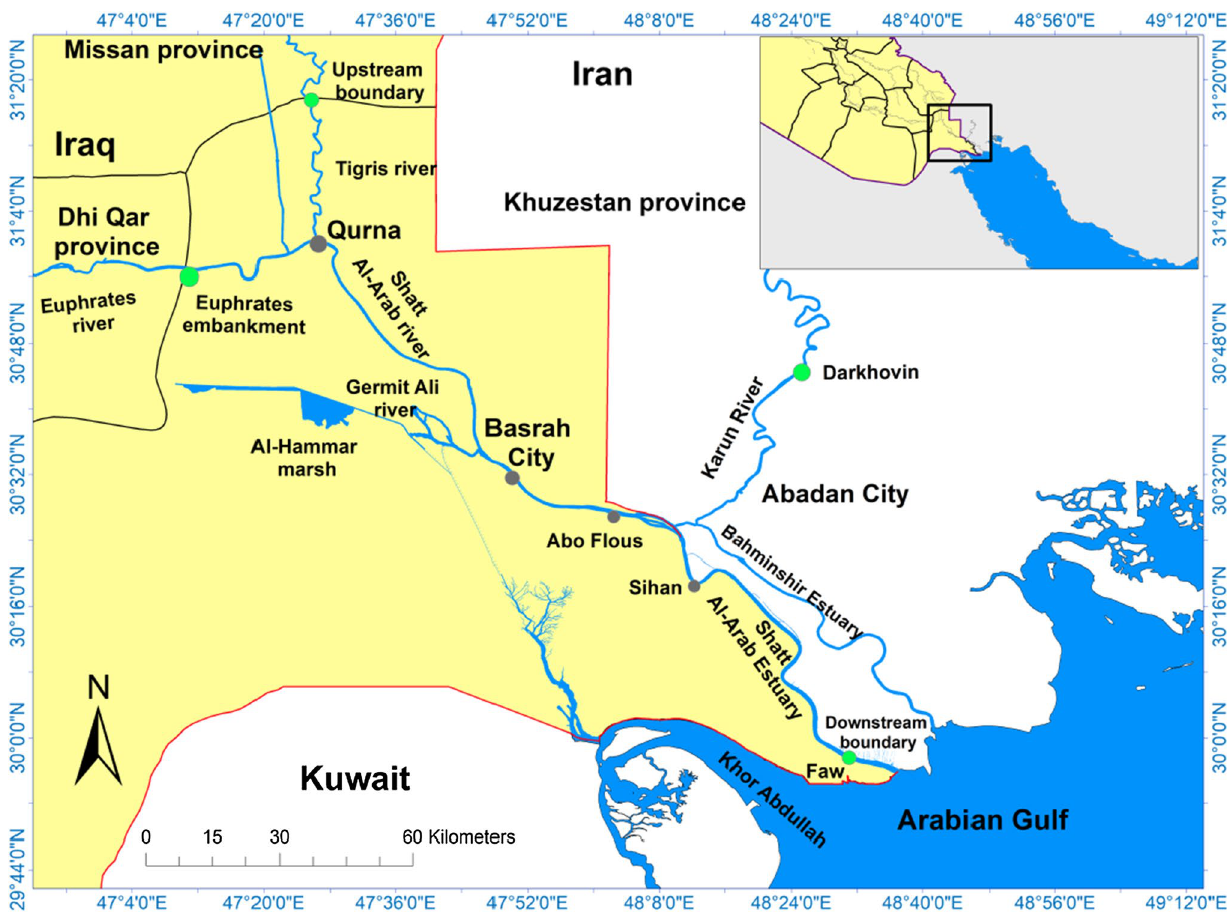
Fig. 1 Map of studied area, including measurements stations as well as model boundaries (green